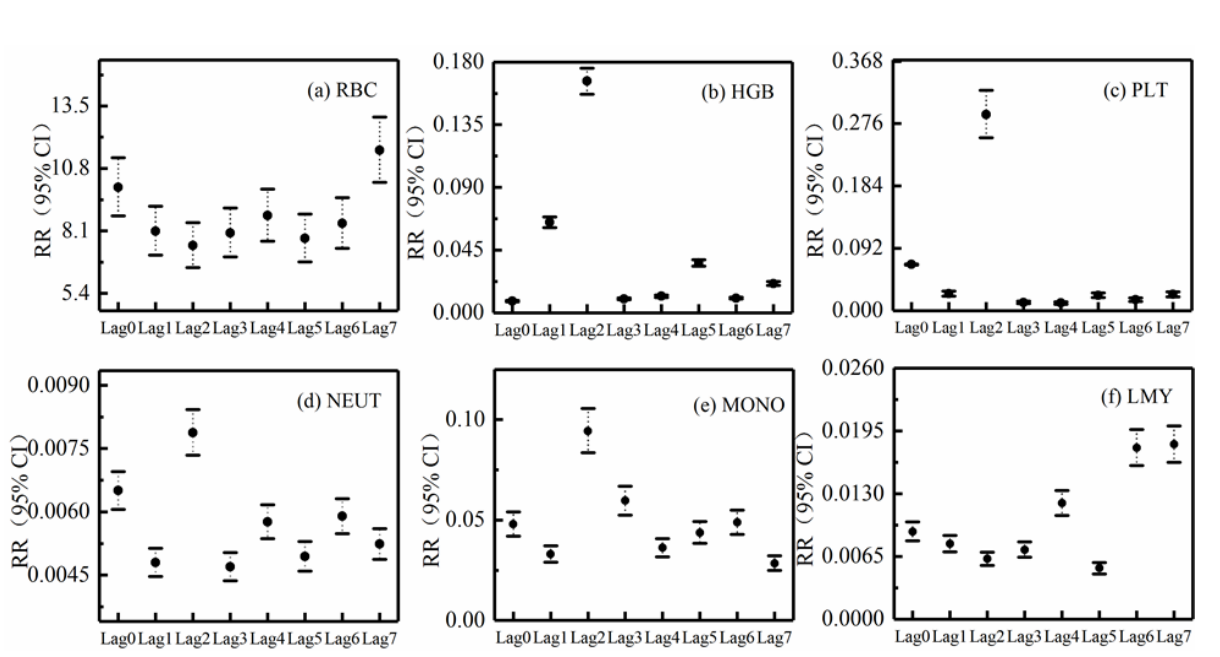
Bold represent significant correlation between PM 2.5 concentration and blood routine parameters at different lag times at p < 0.05. P, level of significance; RR, relative risk; WBC, white blood cell count; MONO (%), monocyte ratio; RBC, red blood cell count; LMY (%), lymphatic ratio; HGB (g/L), hemoglobin; PLT, platelet count; NEUT (%), neutrophil ratio.